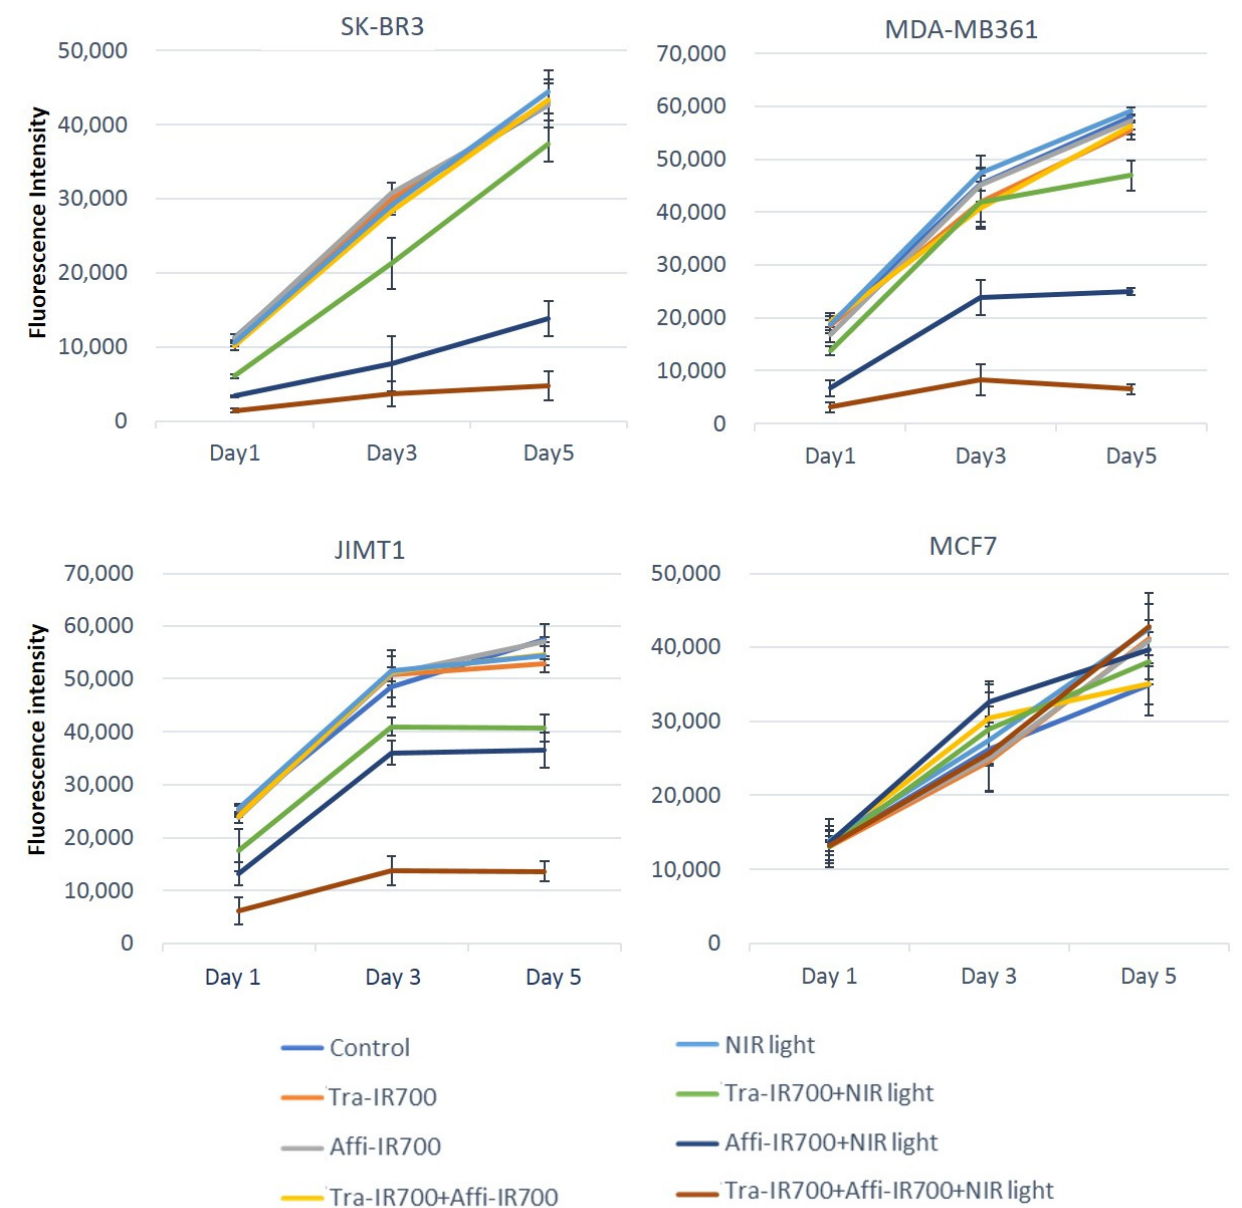
Figure 5. alamarBlue assay showed cell viability as fluorescence intensity. After NIR-PIT using HER2 Affibody-IR700Dye conjugate and/or trastuzumab-IR700Dye conjugate, the cell viability of SK-BR3 (0–0.1 µ M, 0–5 J/cm 2 ), MDA-MB361 (0–0.2 µ M, 0–20 J/cm 2 ), JIMT1 (0–0.3 µ M, 0–50 J/cm 2 ), and MCF7 (0–0.3 µ M, 0–50 J/cm 2 ) cells was measured for an extended period of 5 days. Only HER2-positive cells (SK-BR3, MDA-MB361, and JIMT1) treated with the combination of NIR-PIT with HER2 Affibody-IR700Dye conjugate and trastuzumab-IR700Dye conjugate maintained the lowest cell viability, whereas all samples of HER2-negative cells (MCF7) increased at the same speed as the control.